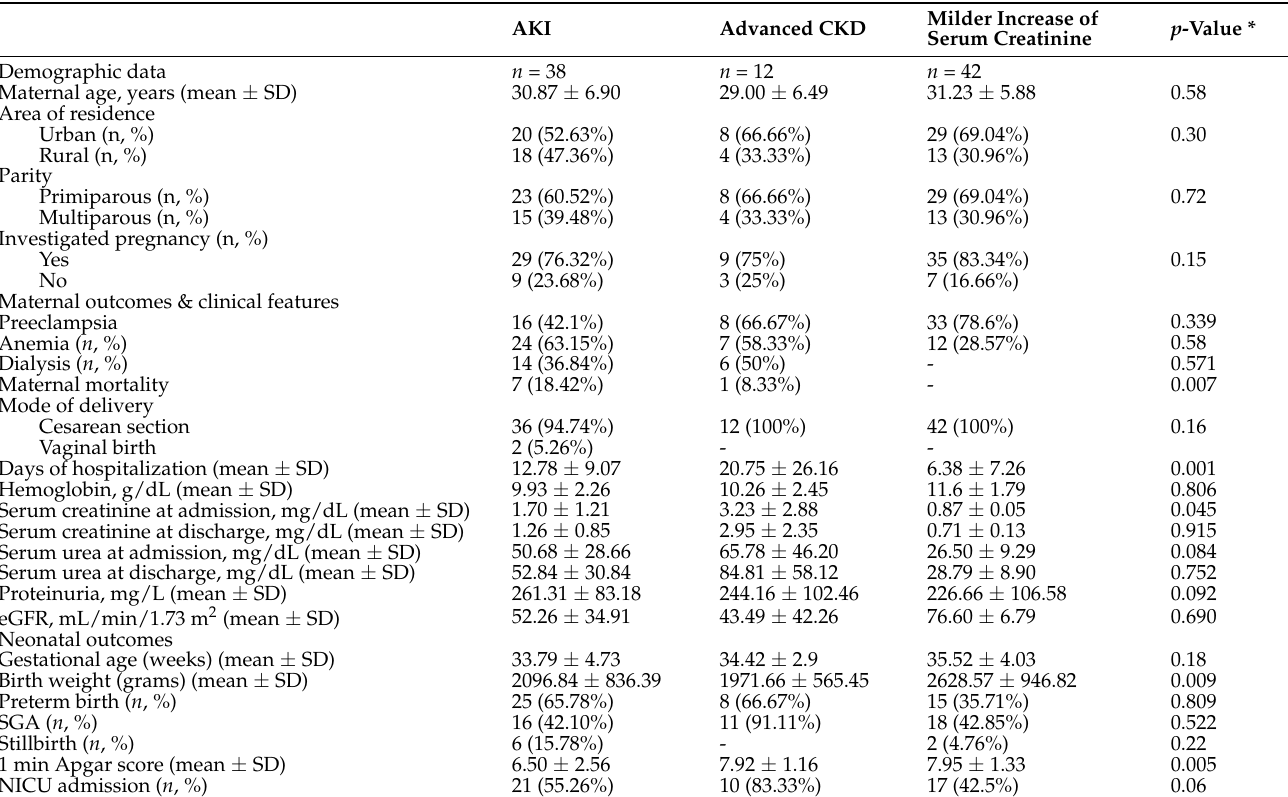
Table 1. Clinical features and maternal/neonatal outcomes.